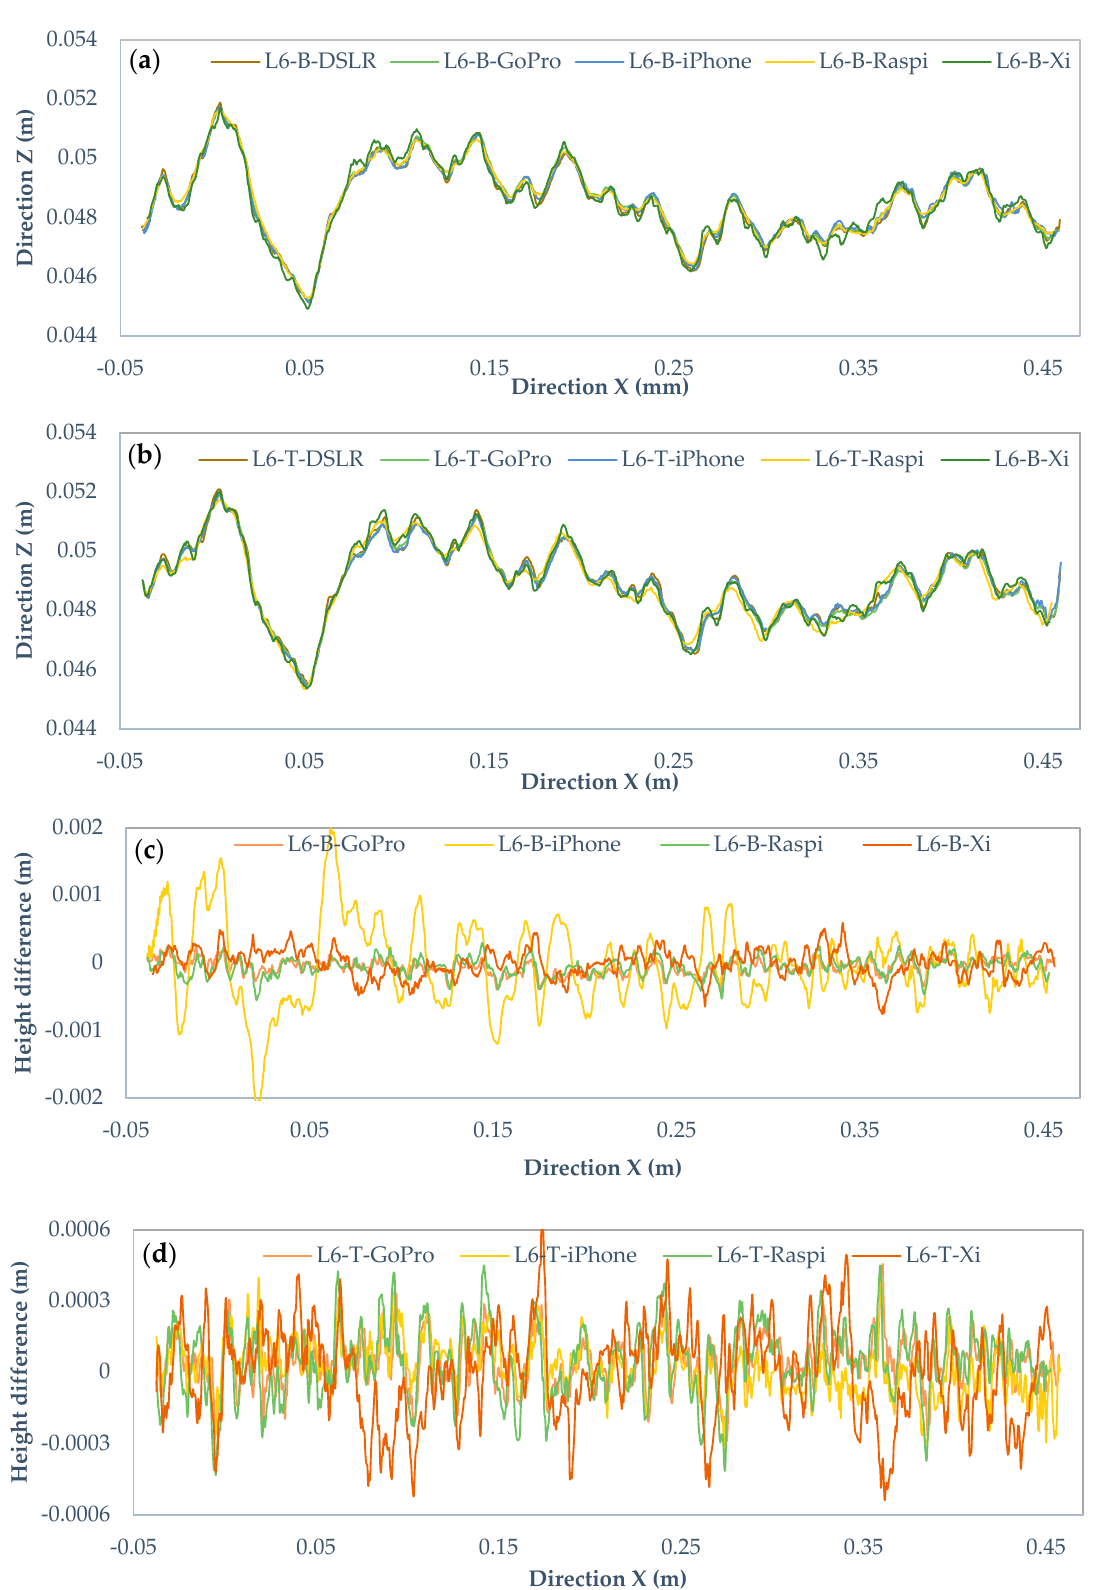
Figure 15. Comparison of the Canon EOS 5DS R DSLR and cameras profiles with 0.5 mm rasterization grid interval. ( a ) Original profiles of bottom surface, ( b ) top surface, ( c ) height differences of bottom profiles, and ( d ) top profiles.